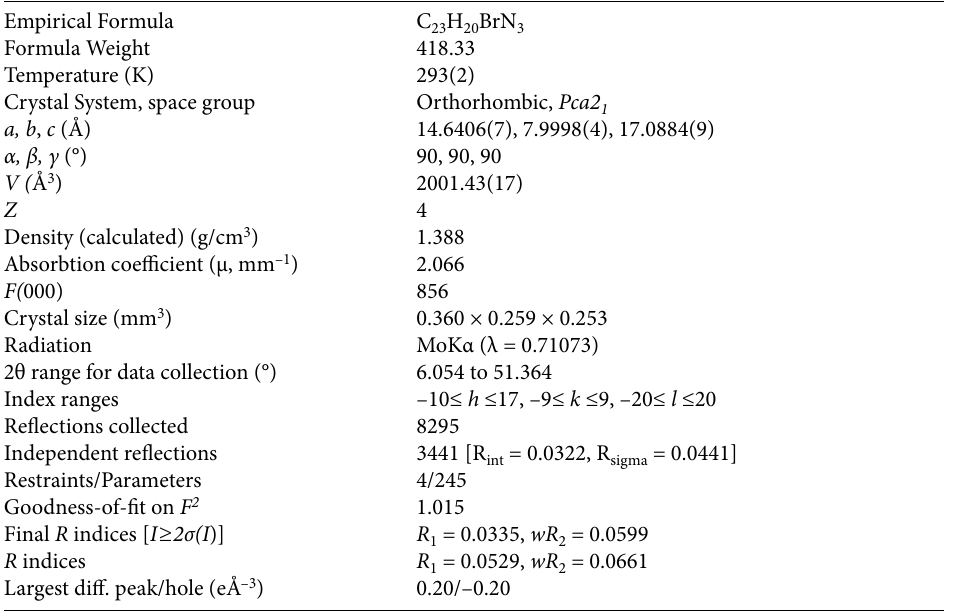
Table 1. Crystal data and experimental details for the compound 2b